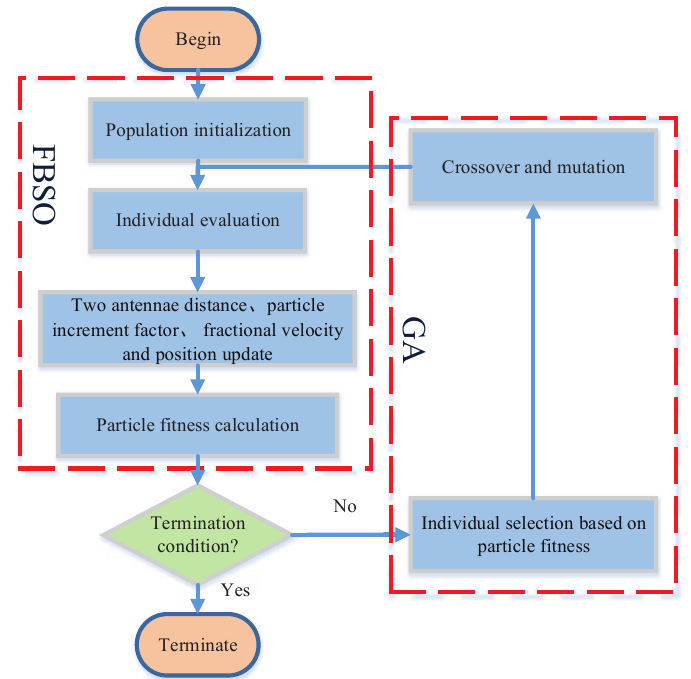
Figure 2. The schematic representation of the HGA-FBSO